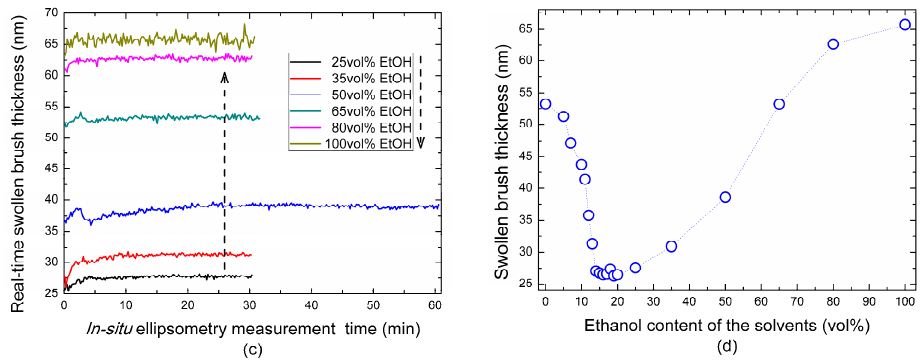
Figure 1. Swollen brush thickness of a PNiPAAm brush ( σ = 0.20 chains/nm 2 ) in aqueous ethanol mixtures as a function of ( a – c ) measurement time and ( d ) ethanol fraction obtained via Vis-spectroscopic ellipsometry. Note that the dashed line in Figure 1d is only used to guide eyesight. The error bars in Figure 1d are neglected because they are quite small (around 0.2 nm).